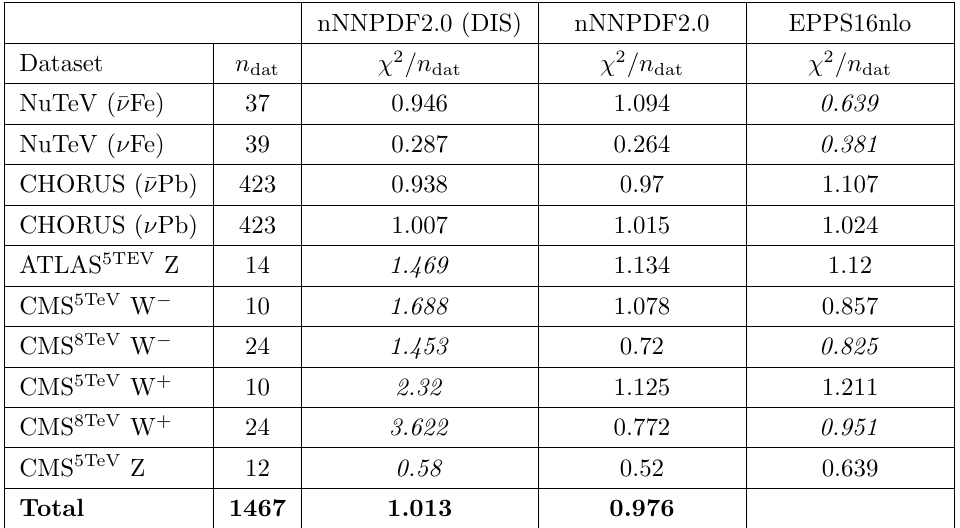
Table 5 . Same as table 4 now for the new datasets included in nNNPDF2.0: charged current DIS structure functions and gauge boson production at the LHC. We also provide the values of (cid:31) 2 =n dat for the total dataset. Values in italics indicate predictions for datasets not included in the corresponding